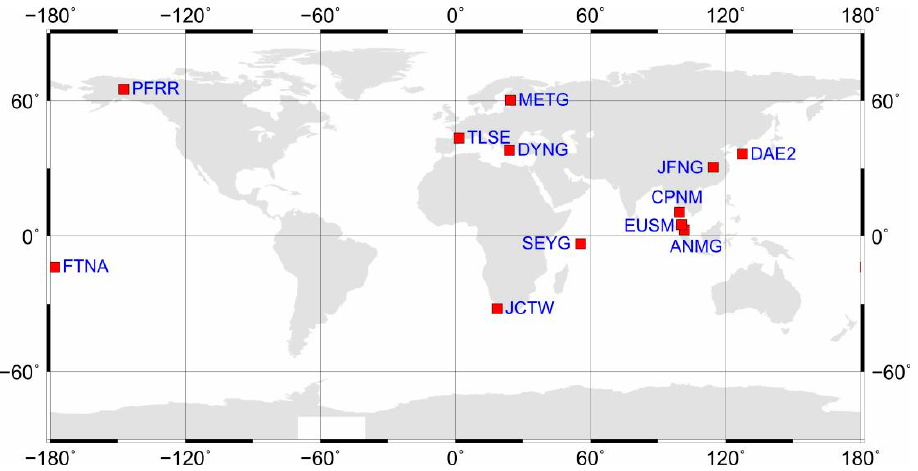
Figure 3. Geographical distribution of 12 MGEX stations.